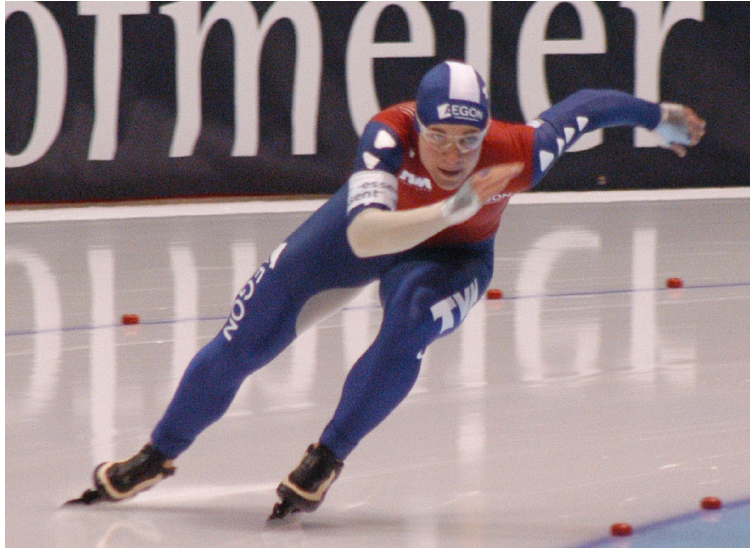
Figure 1: A speed skater rounding a curve. Photograph of the skater Paulien van Deutekom, by McSmit [ CC BY-SA 3.0 Wikimedia Commons ]